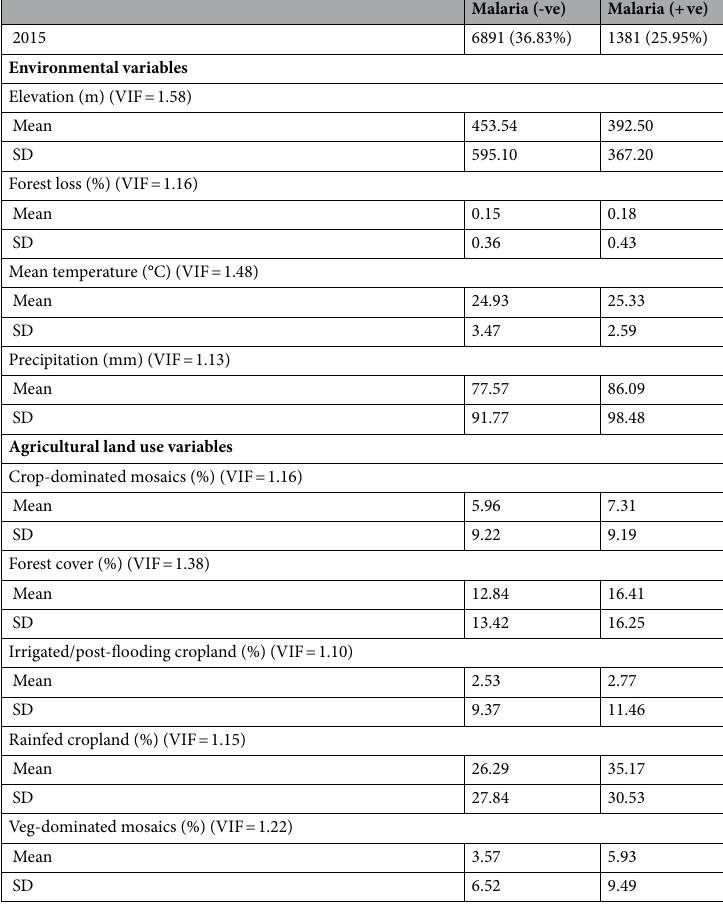
Data were collected between the years of 2010 until 2015, with 12.42% of samples collected in 2010, 11.53% in 2011, 24.89% in 2012, 7.34% in 2013, 9.41% in 2014 and 34.42% in 2015. Countries include Angola (5.66%), Burkina Faso (5.24%), Benin (5.07%), Burundi (8.43%), Cote D’Ivoire (4.34%), Ghana (2.57%), Guinea (2.32%), Mali (5.68%), Mozambique (7.88%), Nigeria (13.93%), Senegal (25.11%) and Tanzania (13.75%). No variables within our dataset presented problems of multicollinearity. We therefore included all variables for analysis (Table 1). Further details including a data flow diagram, additional descriptive results and a correlation matrix of all variables can be found in Supplementary Information Dataset 1. Sub‑Saharan Africa multivariate analysis. At the regional level across all 12 countries, a “U-Shaped” relationship was found across land use classes and the odds of childhood malaria, when ordered to reflect the transitions from natural to fully converted land; that is, natural forest cover (highest odds) to mosaics (low- est odds) through to intensive agriculture (intermediate odds) (Fig. 2). Here, the greatest odds were observed for exposure to complete forest cover (no agricultural land use), which was associated with 35% (OR 1.35, CI 1.24–1.47) increased odds of childhood malaria. In contrast, mosaic vegetation structures that include cropland but remain dominated by natural vegetation were not associated with childhood malaria, and mosaics that are dominated by crops but also include natural vegetation were marginally negatively associated with the odds of childhood malaria (OR 0.96, 0.92–1.00). This represents the only land use class that potentially neutralises or while exposure to rainfed cropland was significantly associated with increased childhood malaria (OR 1.13, CI 1.05–1.21). When considering environmental confounders, no significant associations were found between malaria infec- tion and forest loss (OR 0.98, CI 0.96–1.01), mean temperature (OR 1.01, CI 1.00–1.01), precipitation (OR 1.00,